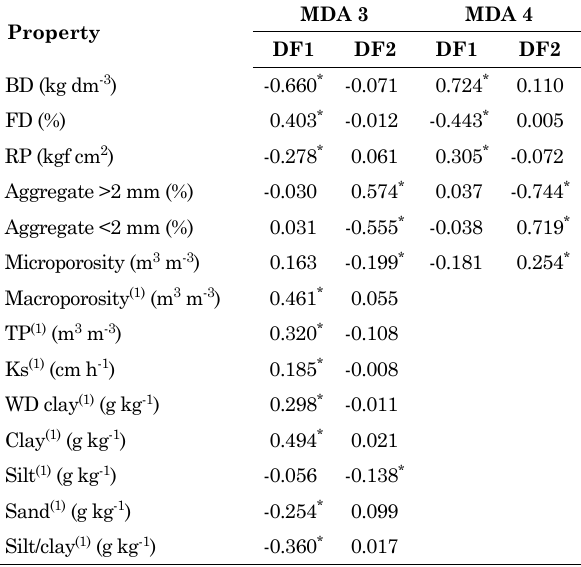
Table 6. Structure matrix coefficients of the soil